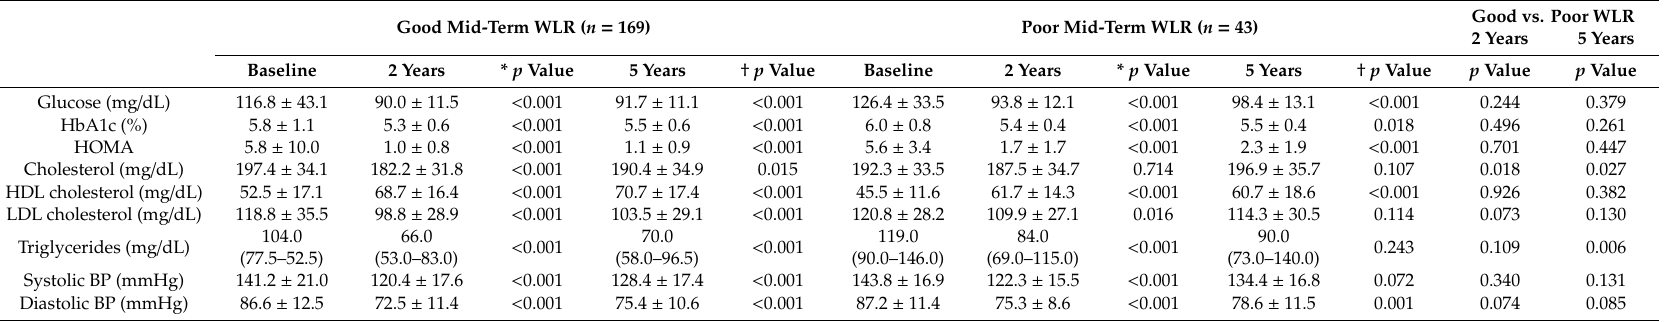
Table 2. Evolution of metabolic markers of good and poor WL at baseline, 2 and 5 years after bariatric surgery.